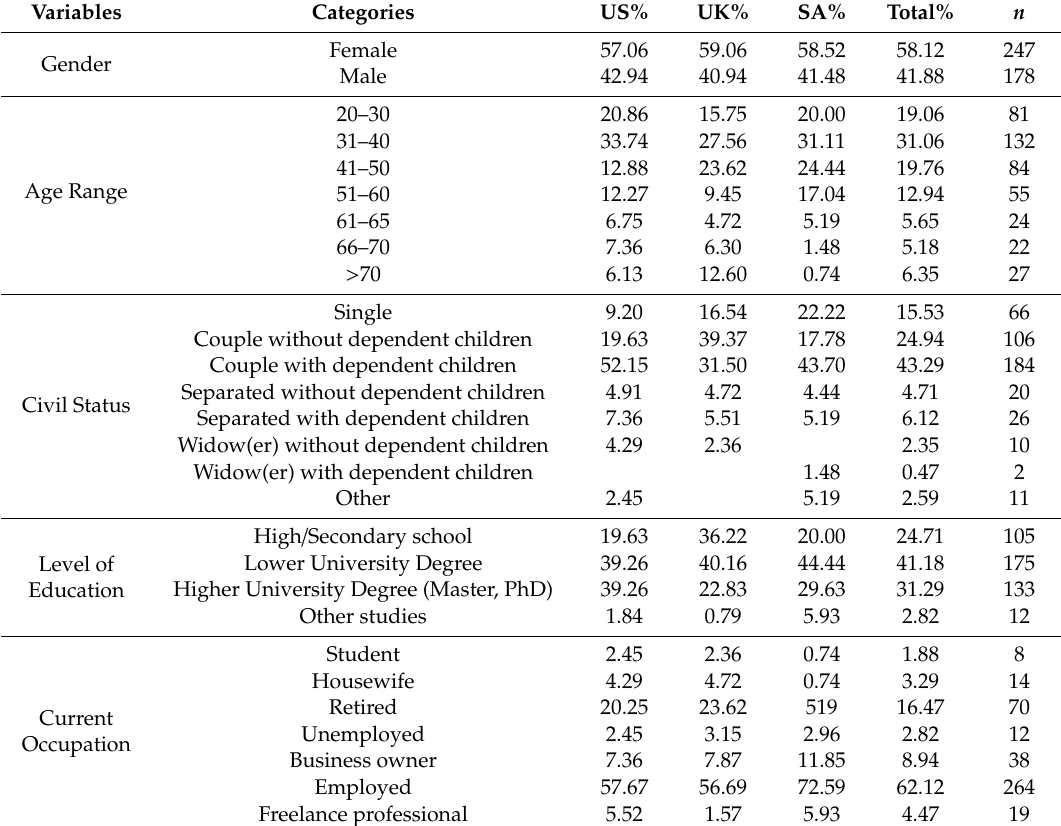
Table 1. Sociodemographic characteristics of the